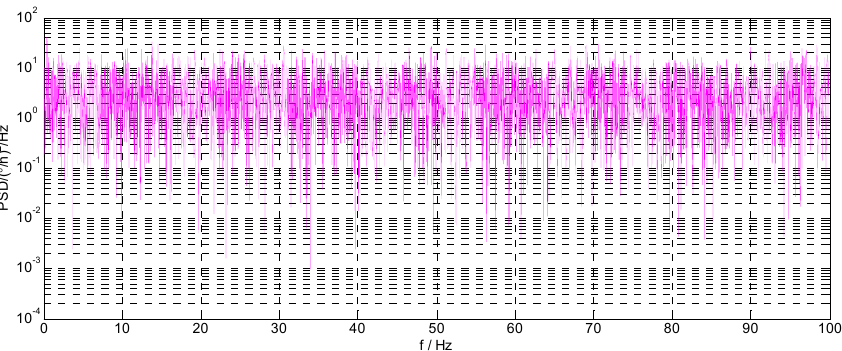
Figure 2. The PSD of the fitting residual error sequence.